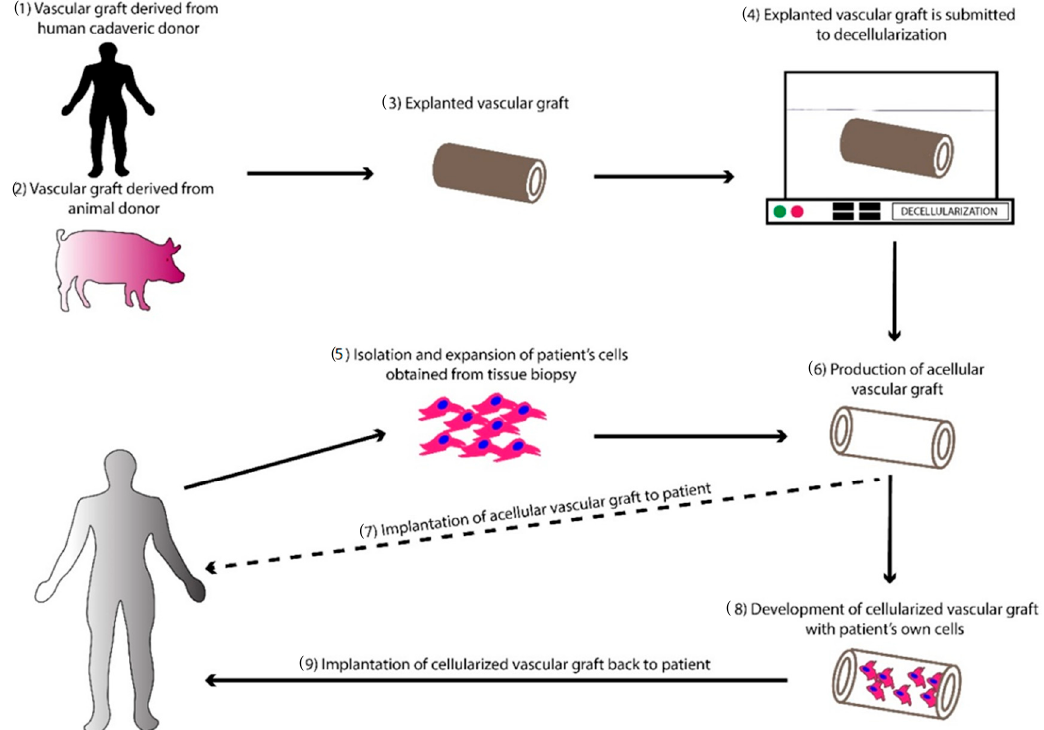
Figure 2. Production of SDVGs with the decellularization approach. Initially, vascular grafts can be obtained either from human cadaveric or animal donor. Then, the obtained SDVG is submitted to decellularization to remove the residual cellular population. The produced acellular vascular graft can be either implanted back to the patient or to submitted in recellularization with the patient’s own cells. The cellular populations can be isolated and expanded from the patient’s tissue biopsy. When cells reached the desired cell number, they can be used for the recellularization of the acellular vascular graft. Finally, the produced cellularized SDVG can be implanted in the patient. The whole procedure can be performed under good manufacturing practice (GMP)